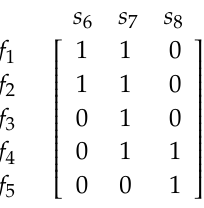
Figure 1. Directed graph of an engineering system: ( a ) a directed graph; ( b ) a cause–effect graph of f 1 ; ( c ) a bipartite graph.